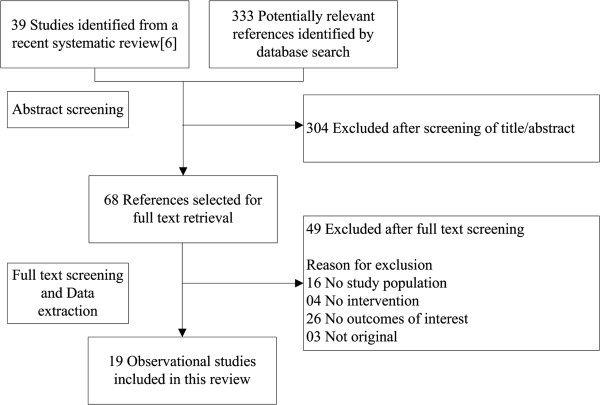
Flow diagram for selection of studies included in the systematic review.